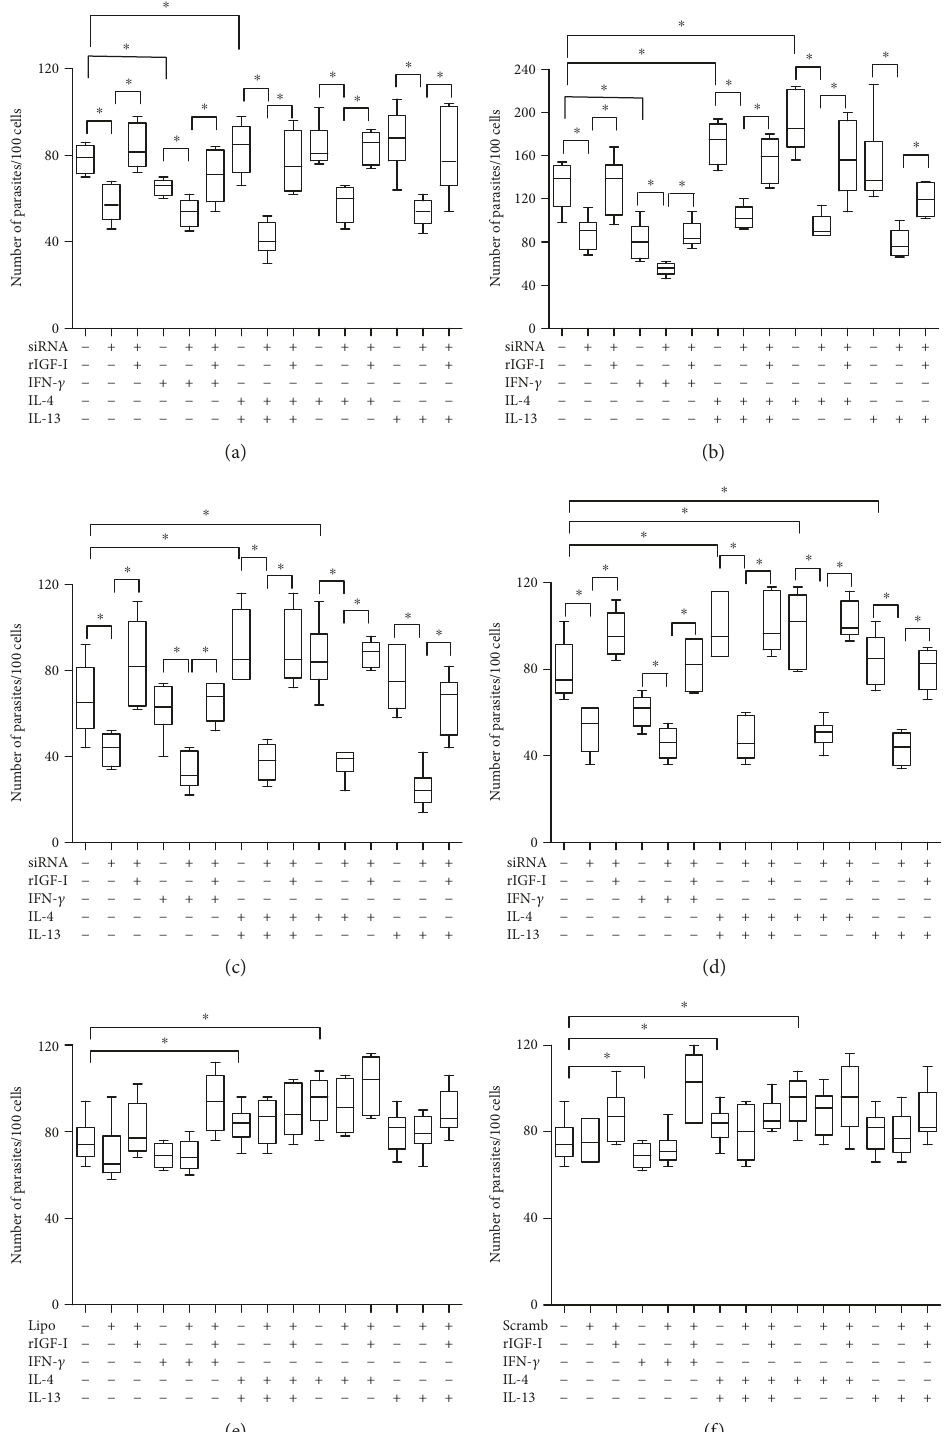
Figure 4: Parasitism in response to cytokine treatments and siRNA transfection. Parasitism (median number of parasites per 100 cells) in L. major -infected RAW 264.7 cells (a, b, e, and f) or BALB/c peritoneal macrophages (c and d) following transfection with IGF-I siRNA (a, b, c, and d), Lipofectamine alone (e), or scrambled siRNA (f) along with cytokine stimulation is shown. Promastigote- (a, c, e, and f) or amastigote-infected (b and d) cells transfected with or without siRNA or Lipofectamine were stimulated with IFN- γ (200U/mL), IL-4 (2 ng/mL), IL-13 (5 ng/mL), and recombinant IGF-I (rIGF-I, 50 ng/mL) for 48 hours. One representative experiment from three independent assays is shown. ∗ P < 0 05 (ANOVA and Tukey ’ s